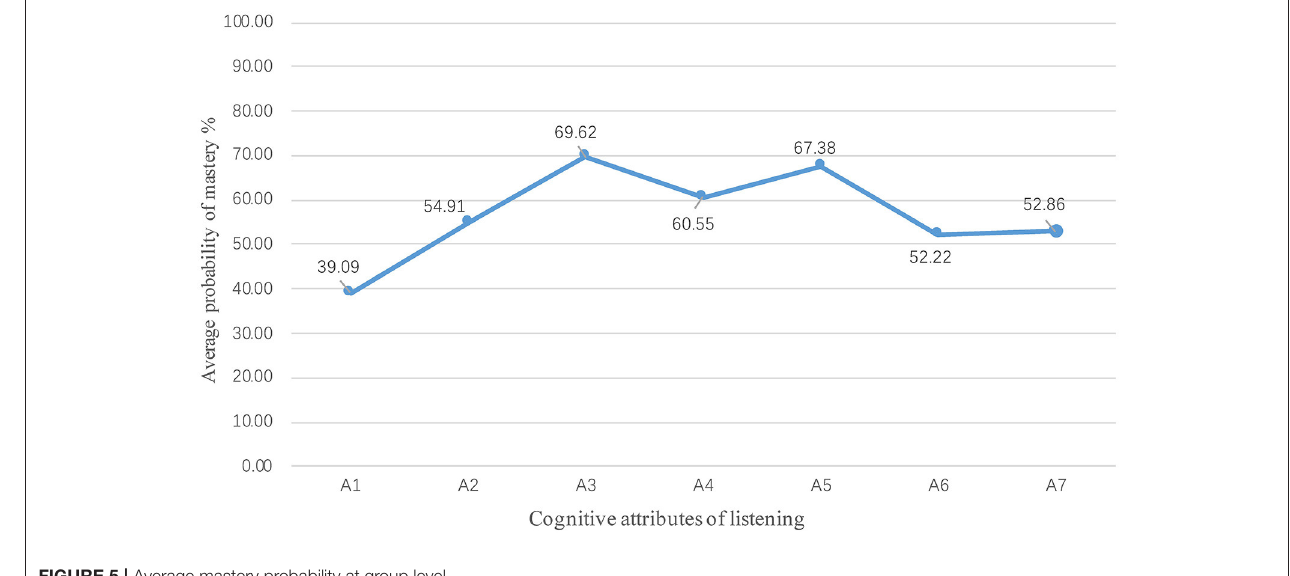
FIGURE 5 | Average mastery probability at group level.